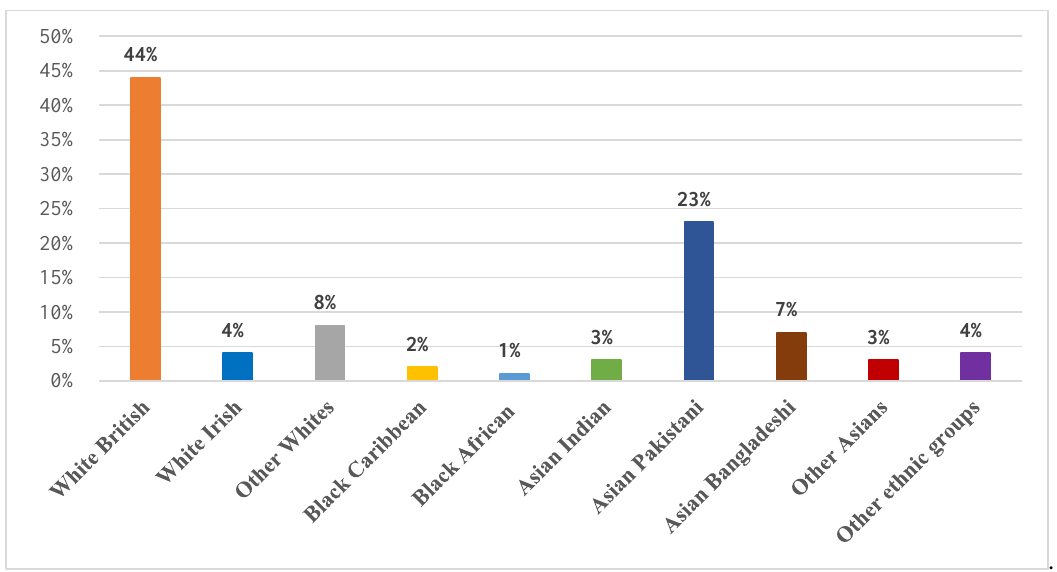
Figure 1. The overall ethnic distribution of the sample ( n = 2807). Table 1. Sample characteristics overall and by study site.